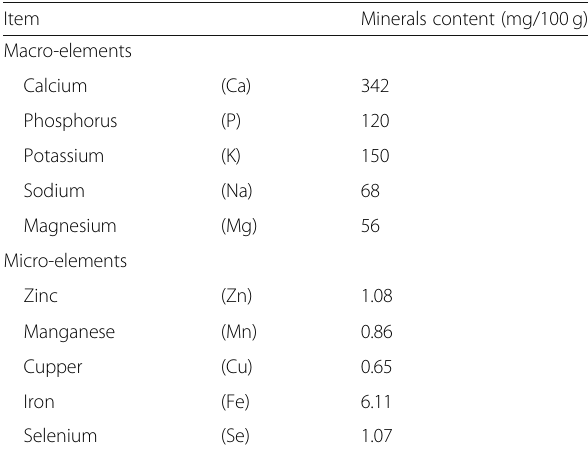
Table 3 Mineral content of dried pomegranate peels (mg/100 g)